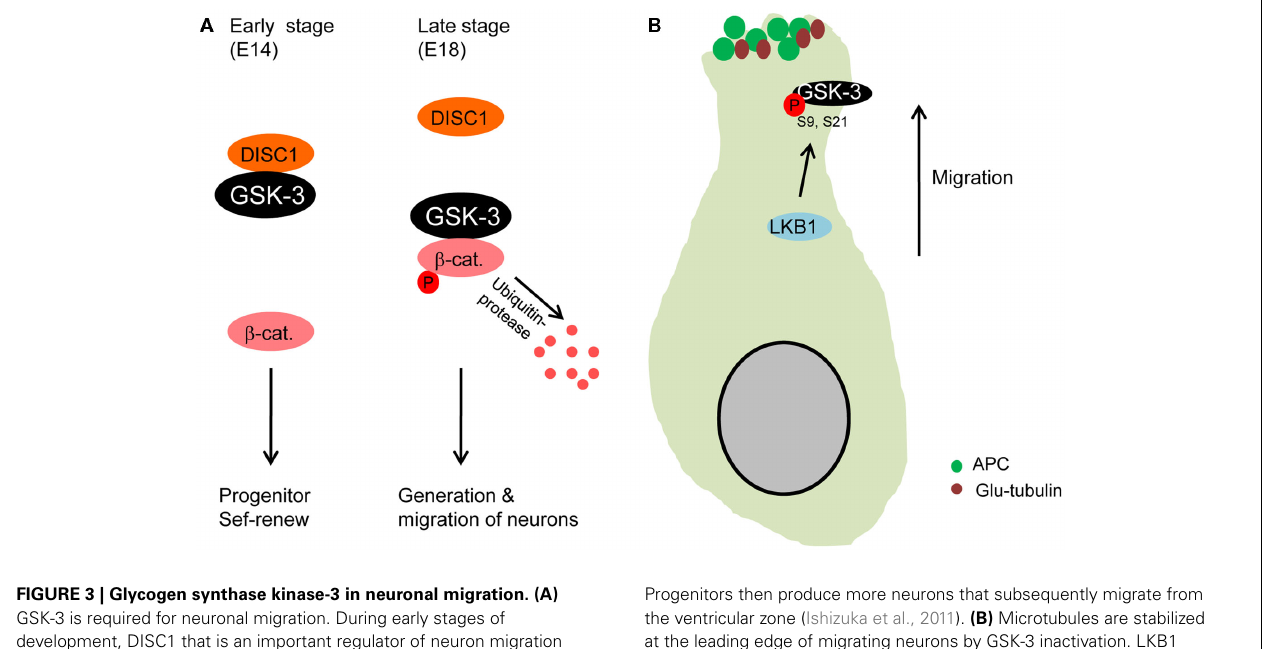
FIGURE 3 | Glycogen synthase kinase-3 in neuronal migration. (A) GSK-3 is required for neuronal migration. During early stages of development, DISC1 that is an important regulator of neuron migration binds to GSK-3, resulting in dissociation of GSK-3 from β -catenin.The increased β -catenin level directs progenitors to self-renew. However, the binding activity of DISC1 decreases at later stages of embryogenesis, which induces reduction in β -catenin level via GSK-3 phosphorylation.